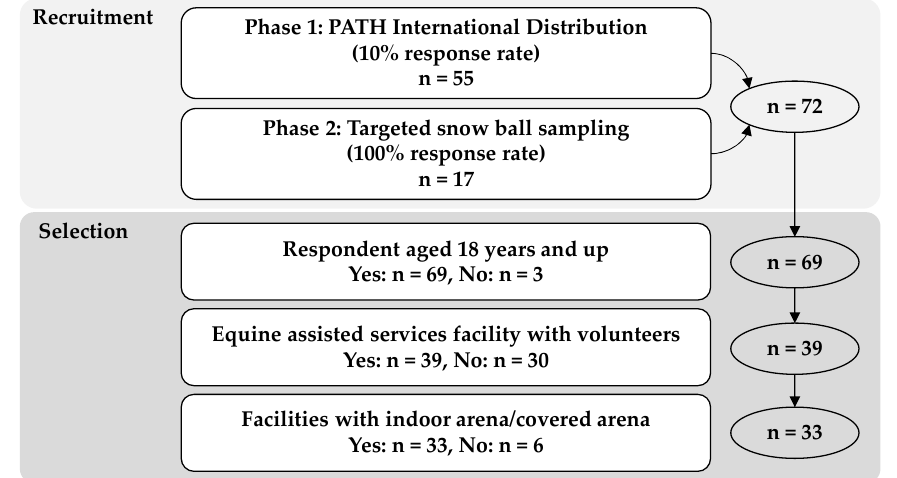
Figure 1. Recruitment flowchart for data analysis.